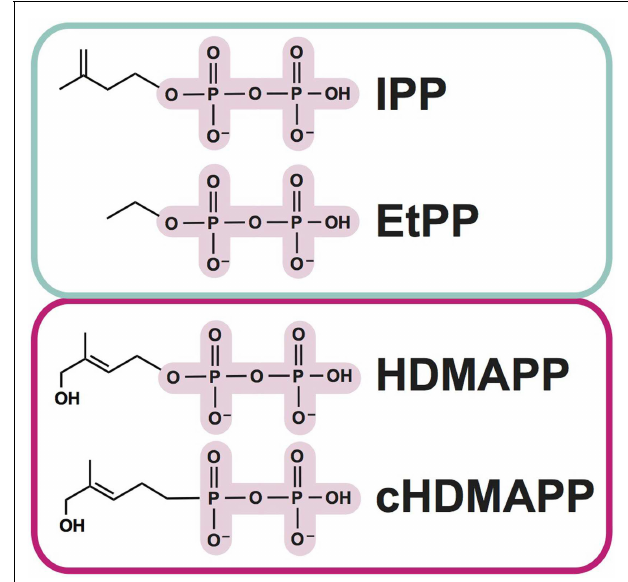
FIGURE 1 | Examples of phosphoantigens (pAgs) that stimulate V γ 9V δ 2T cells . Phosphoantigens (pAgs) that derive from the mevalonate pathway (“endogenous” IPP and synthetic derivative EtPP) are circled in blue whereas those that produced in the isoprenoid pathway of microbes (“exogenous” HDMAPP or synthetic derivative cHDMAPP) are circled in pink.The pyrophosphate motif is highlighted in pink; the chemically diverse organic moieties are shown as